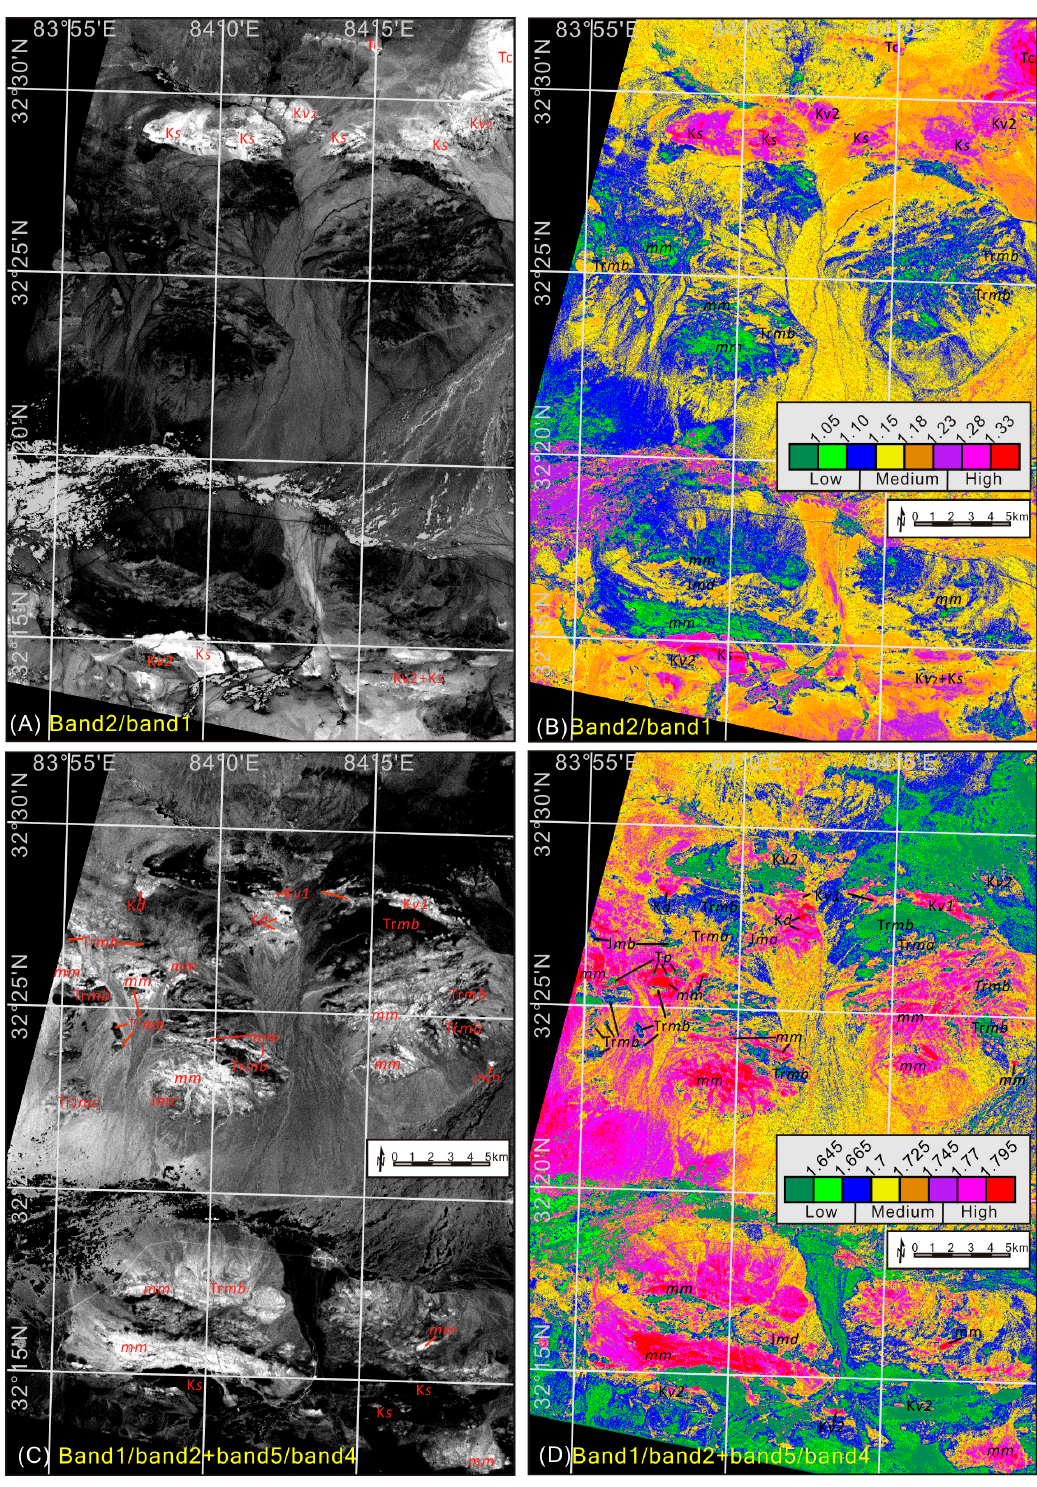
Figure 10. Grayscale and classified color images of VNIR band ratios. ( A , B ) Band ratio band 2/band 1; ( C , D ) Band ratio ( band 1/band 2 + band 5/band 4 ) . See text and Figure 8 for interpretation of the labels of lithologic units.